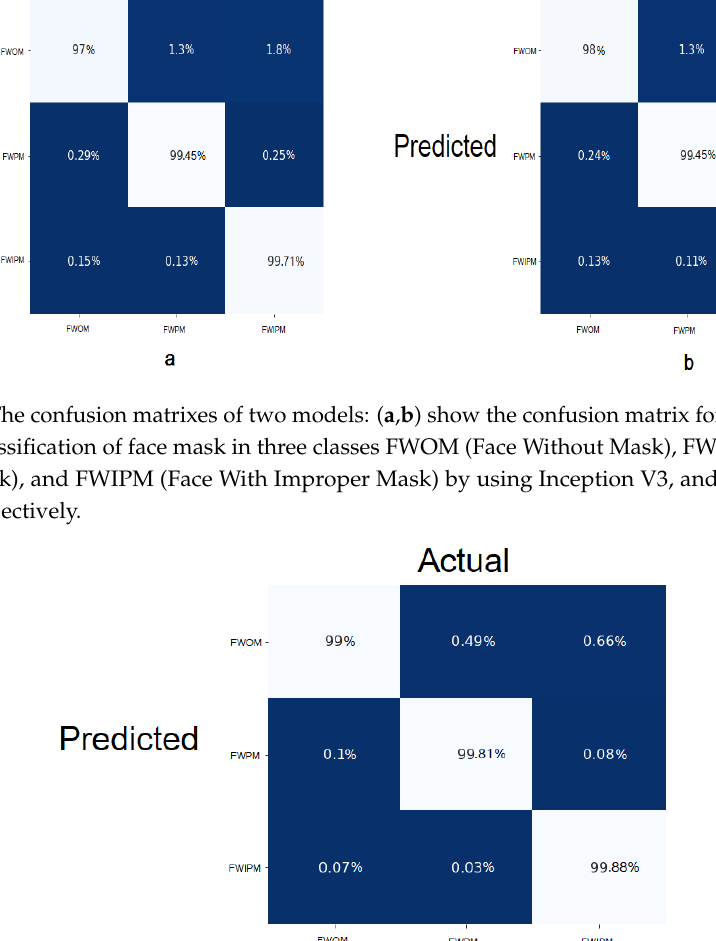
Figure 16. The confusion matrix for the identification and classification of face mask in three classes FWOM (Face Without Mask), FWPM (Face with Proper Mask), and FWIPM (Face With Improper Mask) by using VGG-16